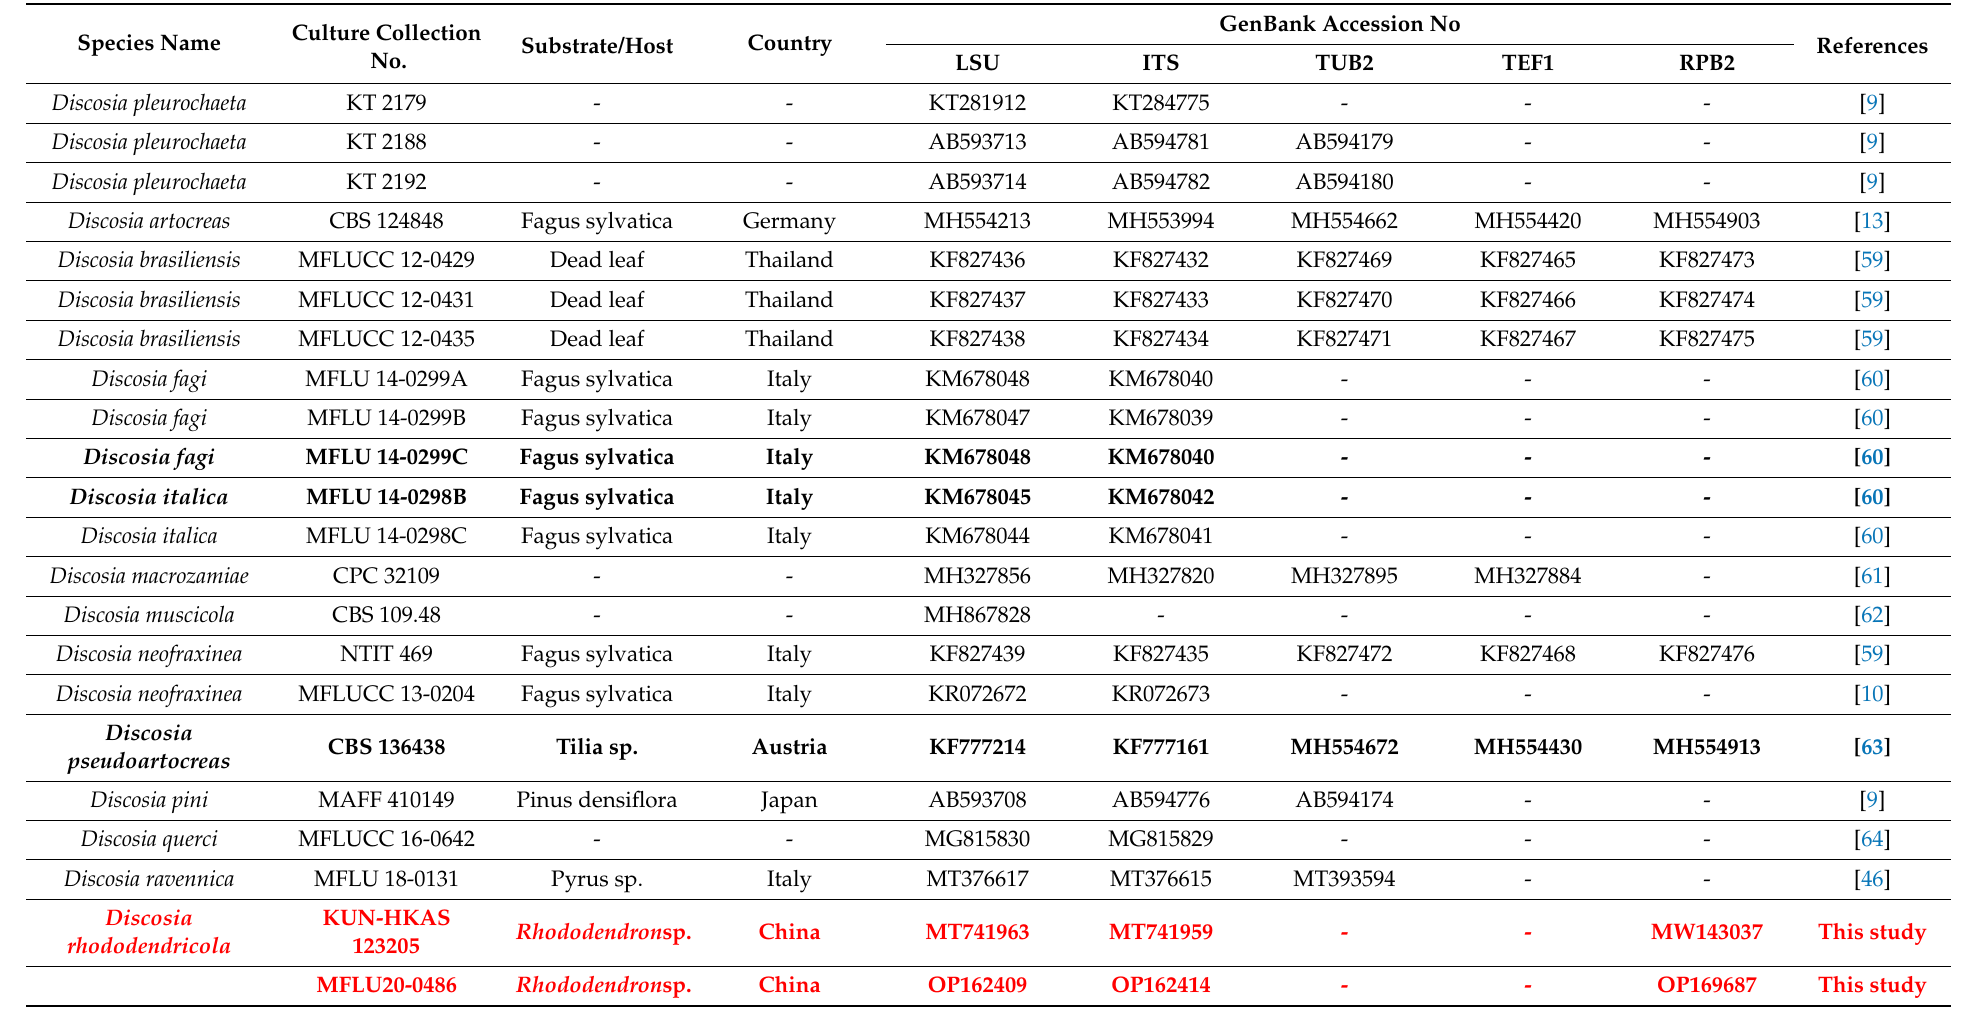
Table 1. Culture collection numbers and GenBank accession numbers for Discosia used in this study. The type species are indicated in bold. The newly generated sequences are indicated in red. Instances where the GenBank Accession No. did not show the molecular data are marked with a